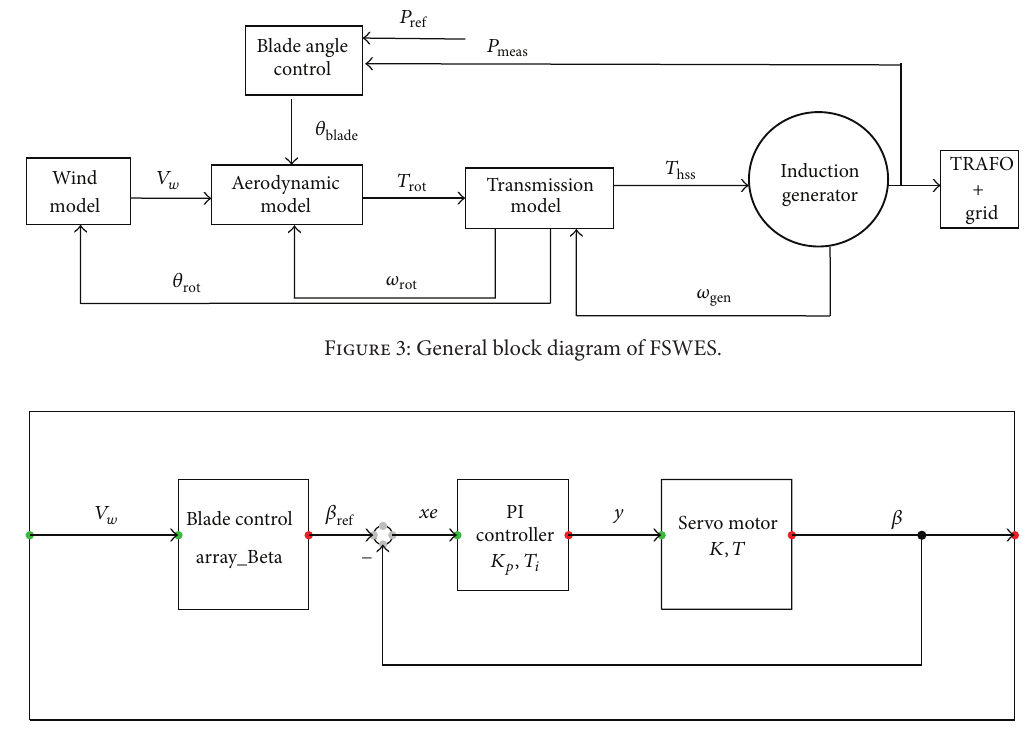
Figure 4: Model for pitch